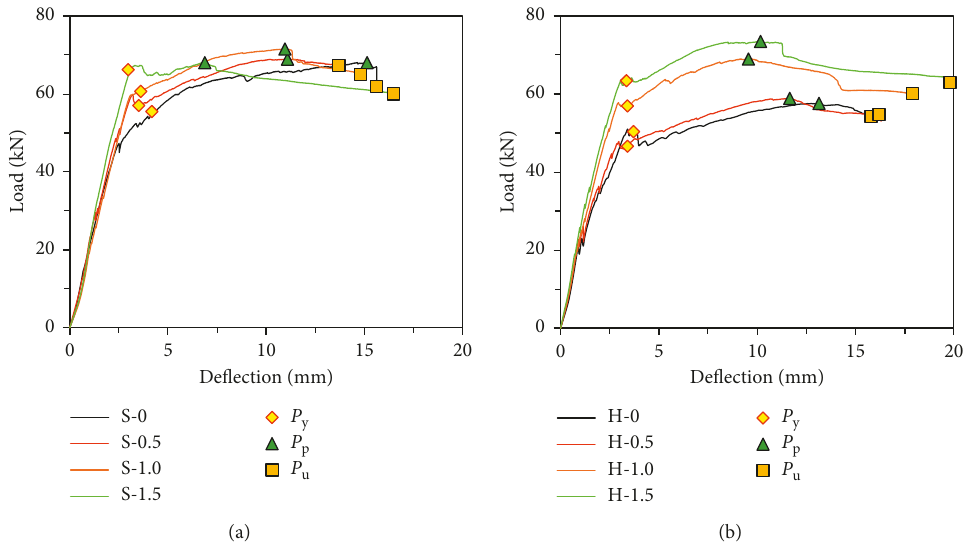
Figure 11: Effect of steel fiber content on load-deflection curves for (a) solid beams and (b) hollow